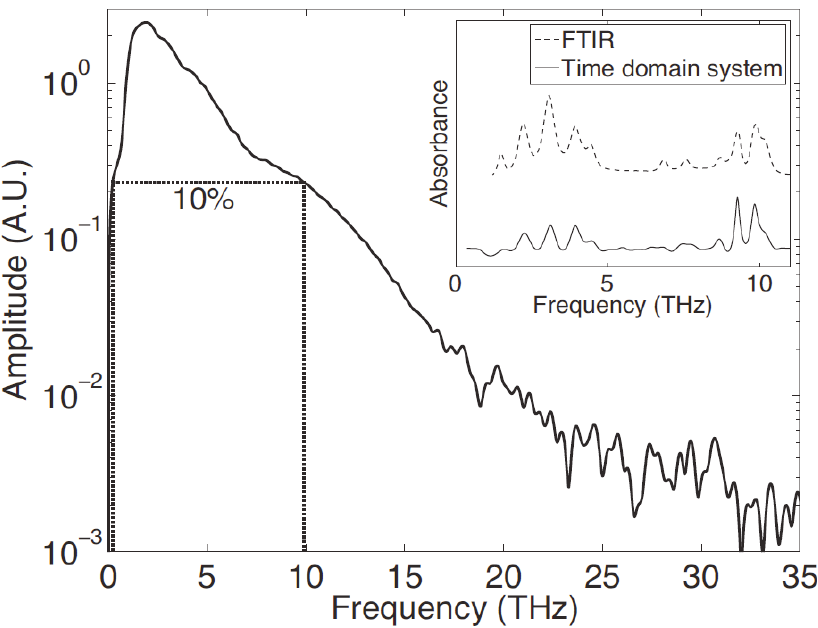
Figure 1. A frequency spectrum covering from 0.1 THz to 35 THz produced by plasma [23].